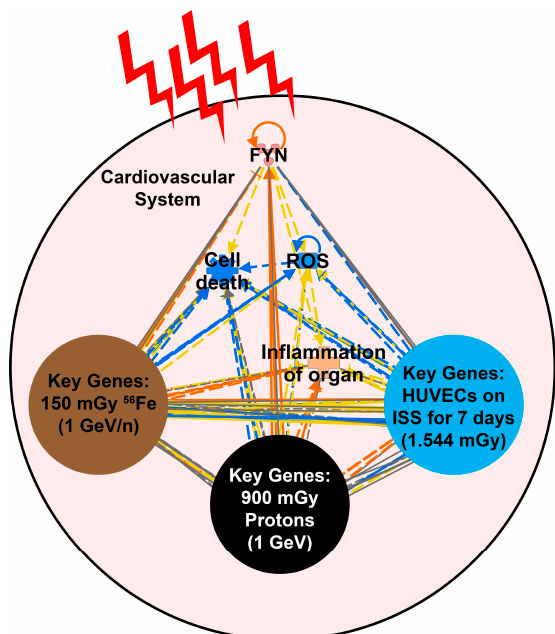
Figure 7. A schematic of the mechanism involved with the space radiation impact on the cardiovascular system. We determined that through the upregulation of FYN (the determined key/central driver involved with space radiation), ROS is downregulated to protect against the upregulation due to space radiation. Although FYN is predicted to be the central player, the other key genes involved from each dataset (Figure 5) will contribute to the reduction in ROS and cell death. In addition, we also observe potential increased cardiovascular health risk due to increased predictions of inflammation.